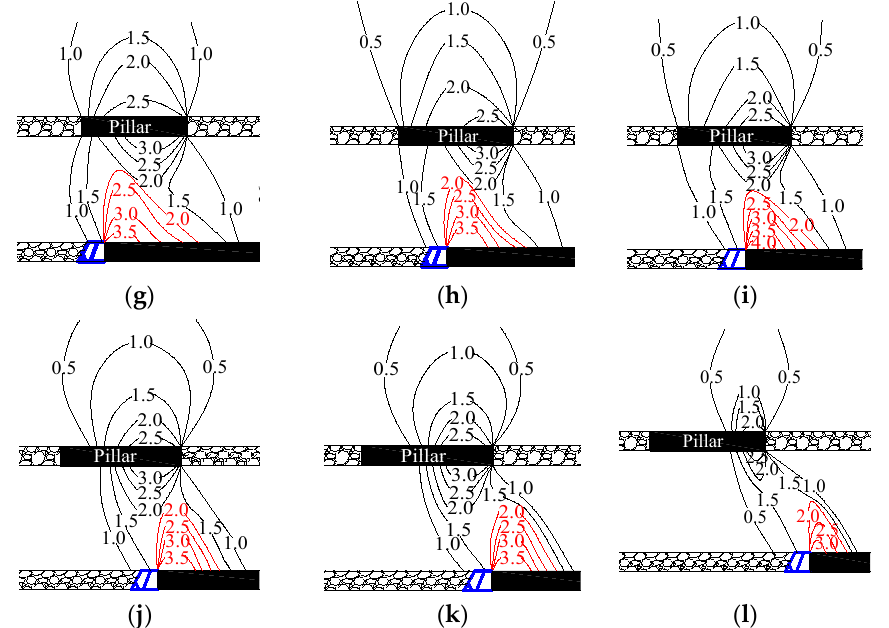
Figure 18. Variation of interburden and pillar stress and FAP by passing coal pillar: ( a ) 30 m before coal pillar, ( b ) 20 m before the coal pillar, ( c ) 15 m before the coal pillar, ( d ) 10 m before the coal pillar, ( e ) 5 m before the coal pillar, ( f ) 0 m into the coal pillar, ( g ) 15 m into the coal pillar, ( h ) 10 m into the coal pillar, ( i ) 15 m into the coal pillar, ( j ) 20 m into the coal pillar, ( k ) 25 m into the coal pillar, and ( l ) 5 m out the coal pillar.